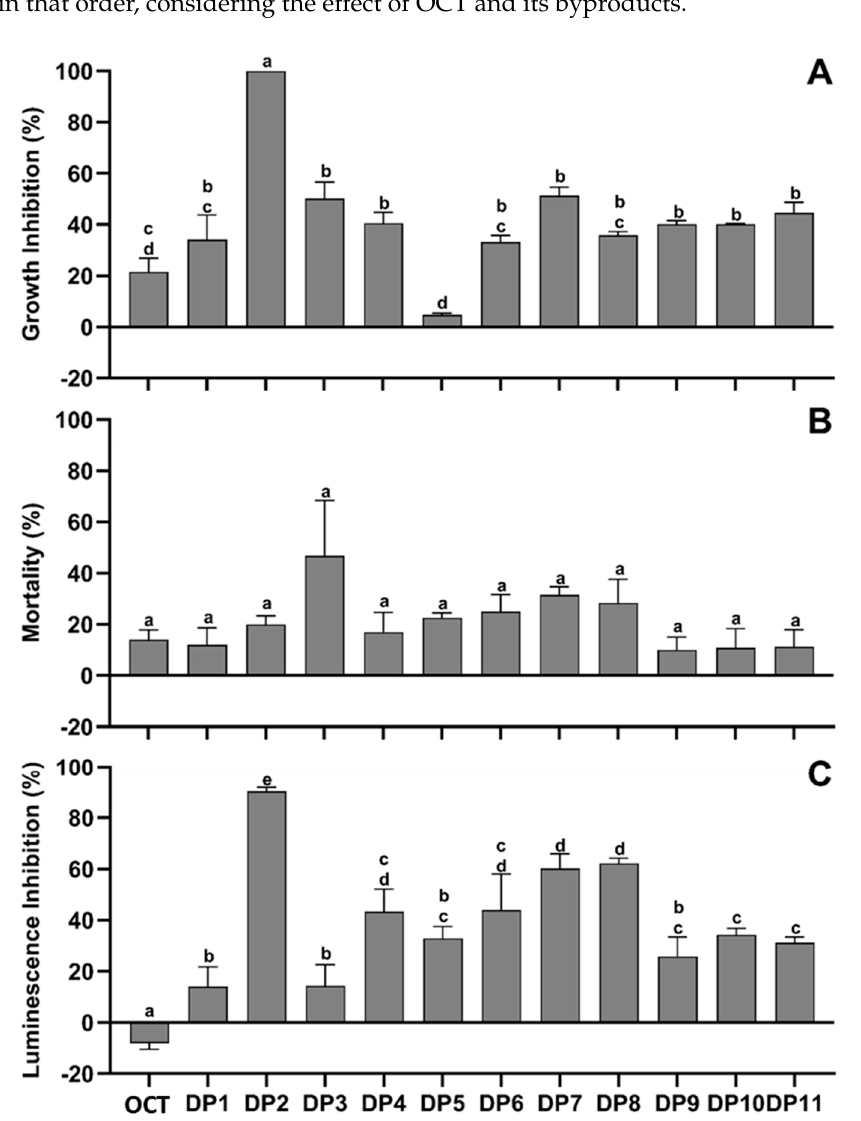
Figure 3. Toxicity data regarding exposure of P. tricornutum ( A ), B. plicatilis ( B ) and A. fischeri ( C ) to OCT and its byproducts ( DP1 - DP11 ). Data with different letters (a–d) are significantly different (Tukey post hoc, p < 0.05).